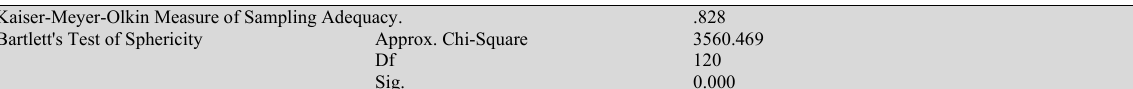
The results of KMO and Bartlett’s test Kaiser-Meyer-Olkin Measure of Sampling Adequacy.